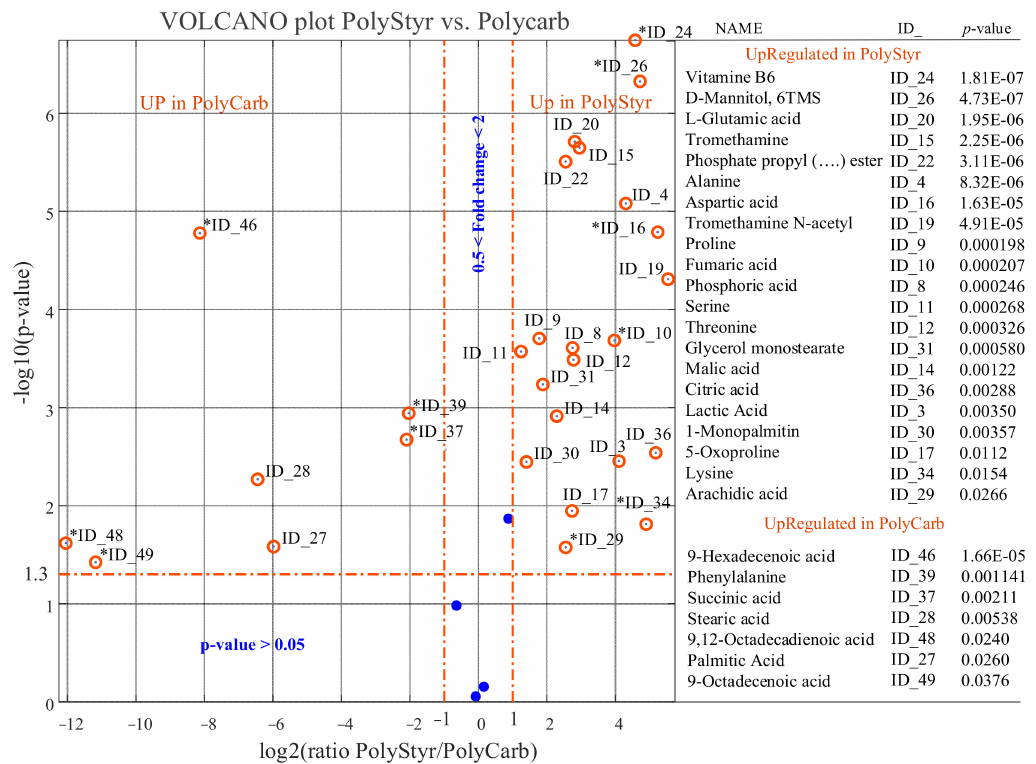
Figure 7. Results of univariate comparison of polystyrene (PolyStyr class) vs. polycarbonate (PolyCarb class). For each metabolite, fold change (FC) is defined as the ratio between mean relative abundances in PolyStyr and PolyCarb classes. Only metabolites with p value < 0.05 and fold changes greater than 2 are considered upregulated in the PolyStyr class, and only metabolites with p value < 0.05 and fold changes lower than 0.5 are considered upregulated in PolyCarb class (orange rings). Blue dots represent metabolites with no significantly different levels in the two compared classes. Fold change of metabolites marked with an asterisk (*) has been evaluated by the data imputation strategy described in the text. Metabolites can be tracked back to identified metabolites in Table 1 through the ID_##